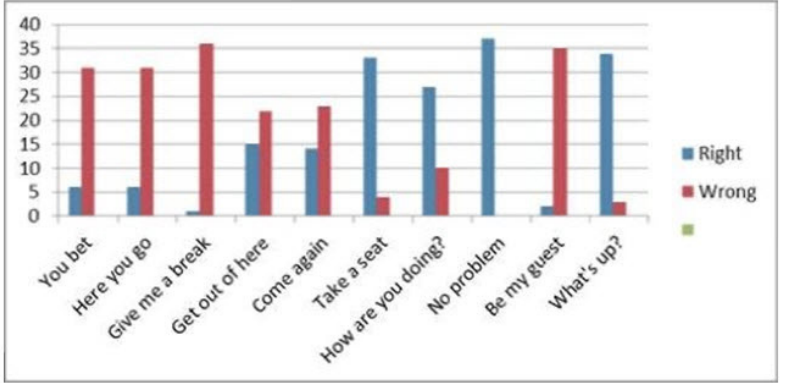
Figure 3. Correlation between correct and incorrect interpretations of situational expressions without the context available (for EG2)